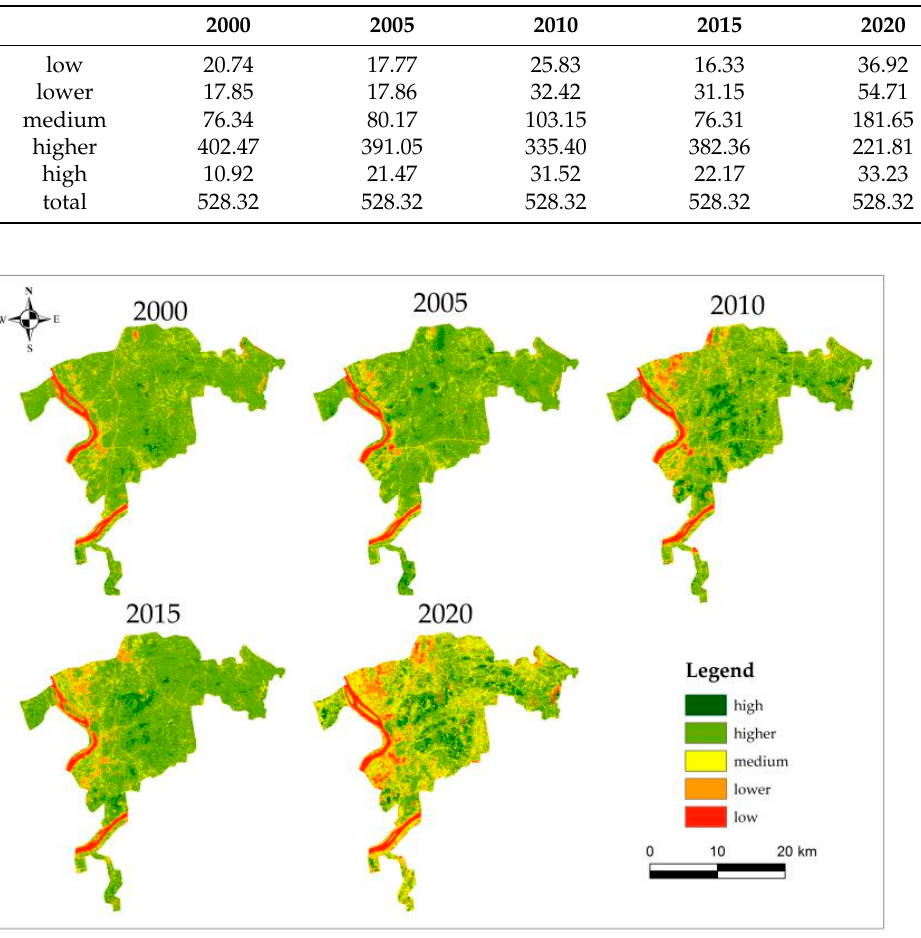
Figure 2. NDVI distribution map of each year.